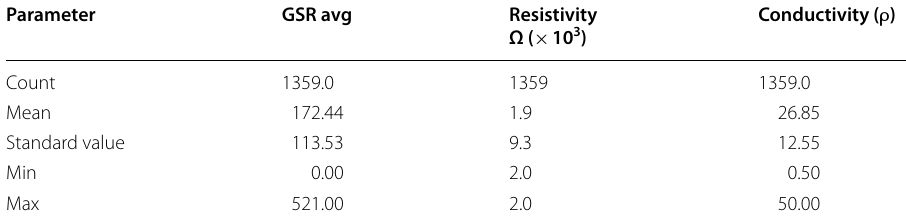
Table5 Statistics of the GSR observations of the subjects for skin conductance and resistance Parameter